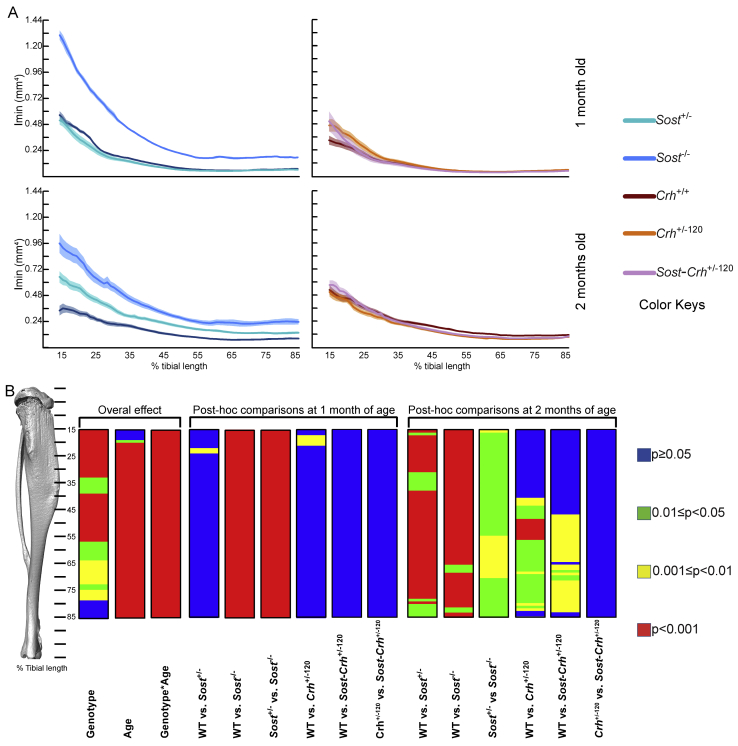
Sost haploinsufficiency does not rescue reduced area around minor axis (Imin) induced by excessive glucocorticoids (GCs). A: Imin in Sost wilt-type (WT) (dark blue; Sost+/+ WT), Sost heterozygous knockout (KO) (light blue; Sost+/−), Sost homozygous KO (turquoise; Sost−/−), Crh WT (dark red; Crh+/+), Crh heterozygous (orange; Crh+/−120), and double Sost-Crh heterozygous (plum; Sost-Crh+/−120) mice at 1 and 2 months of age. Lines represent the means; shading, the SEM. B: Graphic heatmap representation of statistical significance of the effect of genotype, age, their interactions as well as post hoc analysis along a 15% to 85% portion of the whole tibia length, excluding proximal and distal metaphyseal bone. n = 8 mice per group.